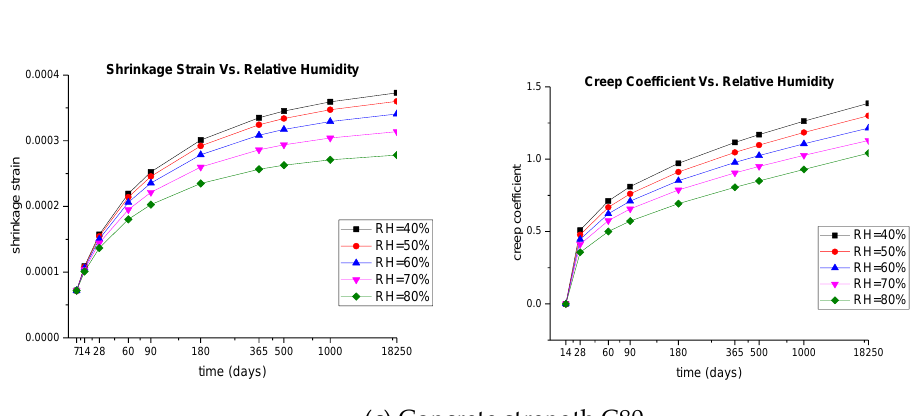
Figure 9. Effect of relative humidity on the time-dependent behaviour of prestressed concrete sleepers.